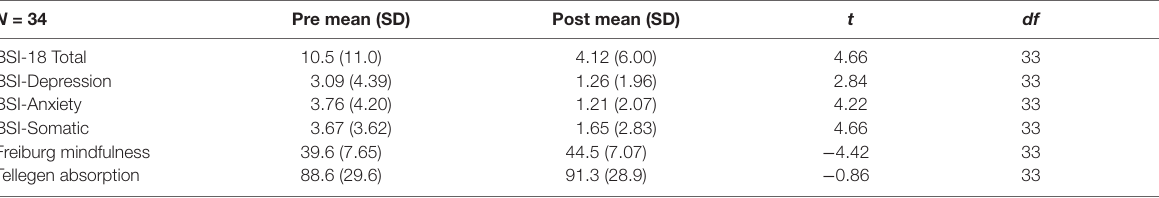
TABLE 2 | Psychometrics pre- and post-retreat.